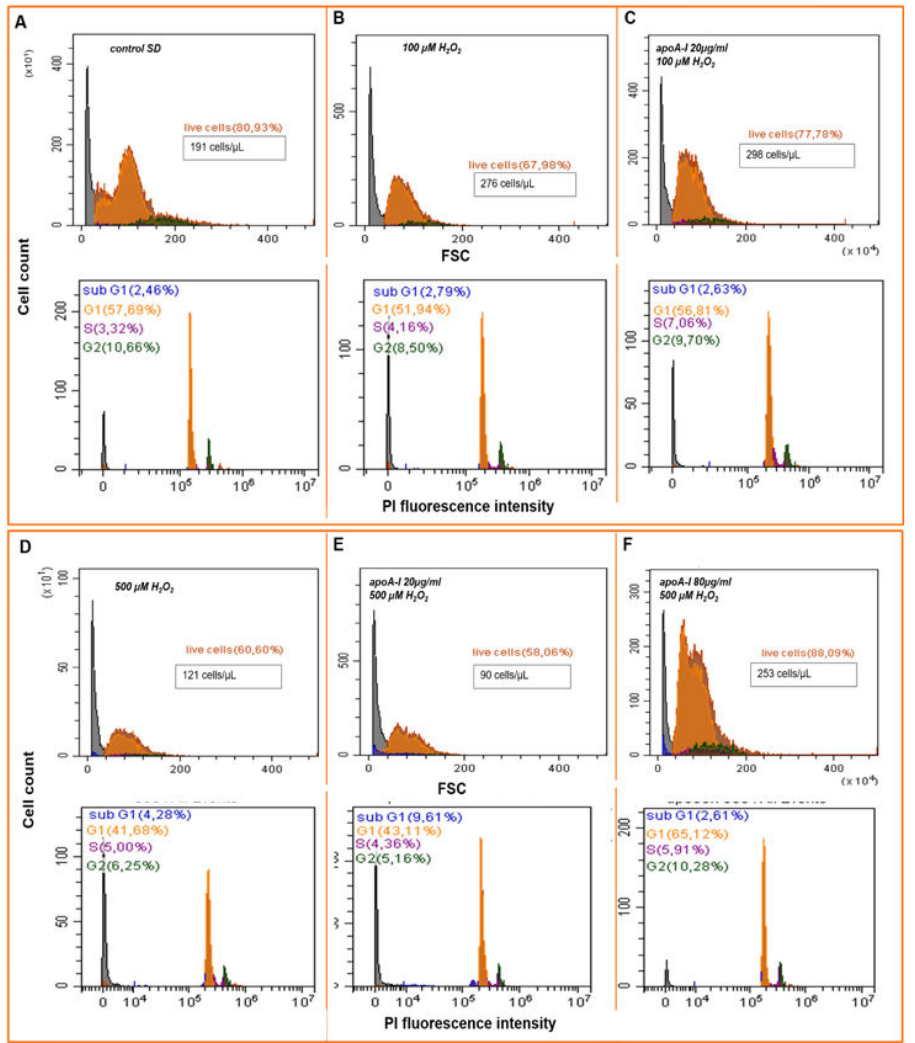
Figure 5. ApoA-I supports MSCs proliferative activity and decreases cell death under peroxidation conditions. ( A – C ) show representative flow cytometry assays of MSCs viability under oxidation by 100 µ M H 2 O 2 . Histograms: A—control SD condition, B—100 µ M H 2 O 2 , C—preconditioning of MSCs by 20 µ g / mL apoA-I followed by adding 100 µ M H 2 O 2 . ( D – F ) show representative flow cytometry assays of MSCs viability under oxidation by 500 µ M H 2 O 2 . Histograms: D—500 µ M H 2 O 2 , E—preconditioning of MSCs by 20 µ g / mL apoA-I followed by adding 500 µ M H 2 O 2 , F—preconditioning of MSCs by 80 µ g / mL apoA-I followed by adding 500 µ M H 2 O 2. Upper panels of ( A – F ) are forward side scatter (FSC) histograms of MSCs content, dead and live cells; bottom panels are FACS histograms of MSCs DNA content reflect cell cycler phases by Propidium Iodite (PI) fluorescent